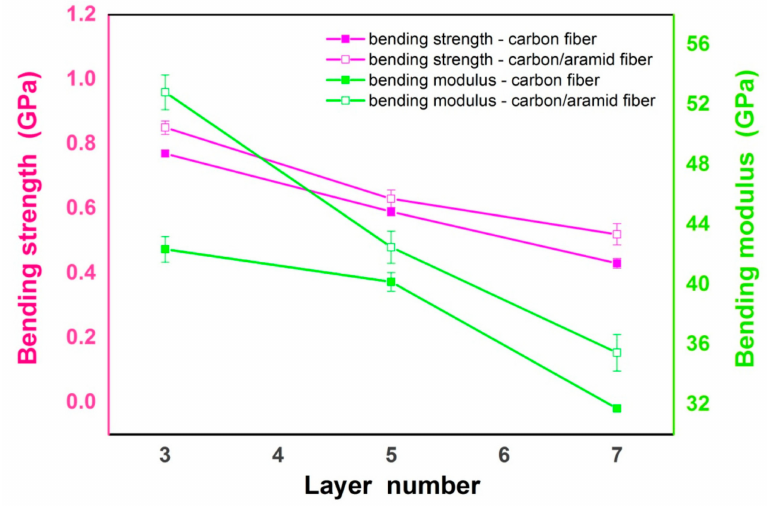
Figure 3. Bending performance of carbon fiber / epoxy composites and carbon-aramid fiber / epoxy sandwich composites with di ff erent layer